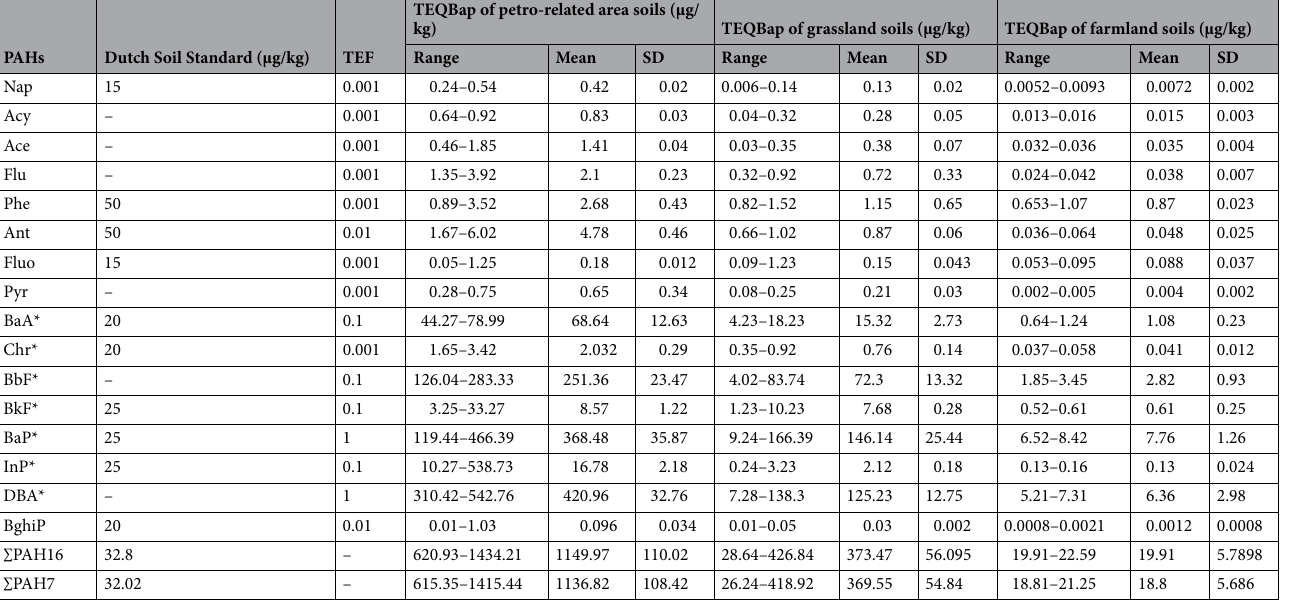
Table 3. Descriptive statistic TEQBap of PAHs in different sampling area. *Indicate carcinogenic PAHs; TEQBap : toxic equivalent quantity based on BaP; ∑PAH16 : sum of 16 converted PAH concentrations based on toxic equivalents of BaP. ∑PAH7 : sum of seven carcinogenic PAHs concentrations based on toxic equivalents of BaP; TEF : toxic equivalency factor; SD : standard